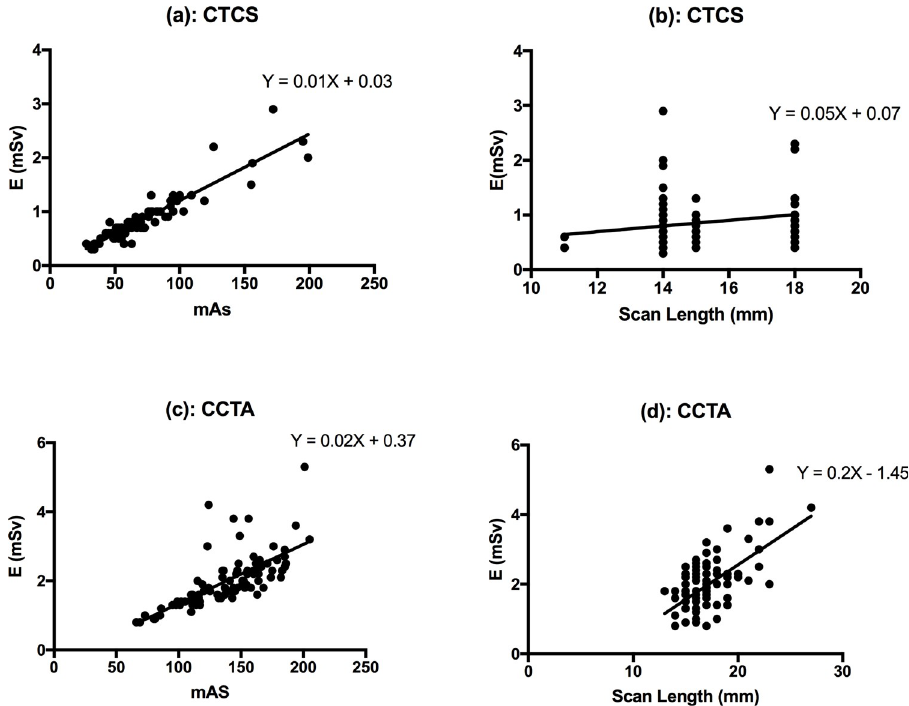
Fig 1. Scattered plot of: (a) effective doses (E) versus tube-current product (mAs) for CTCS; (b) effective doses (E) versus scan lengths (mm) for CTCS, (c) effective dose (E) versus tube-current product (mAs) for CCTA and;(d) effective doses (E) versus scan lengths (mm) for CCTA across all 87